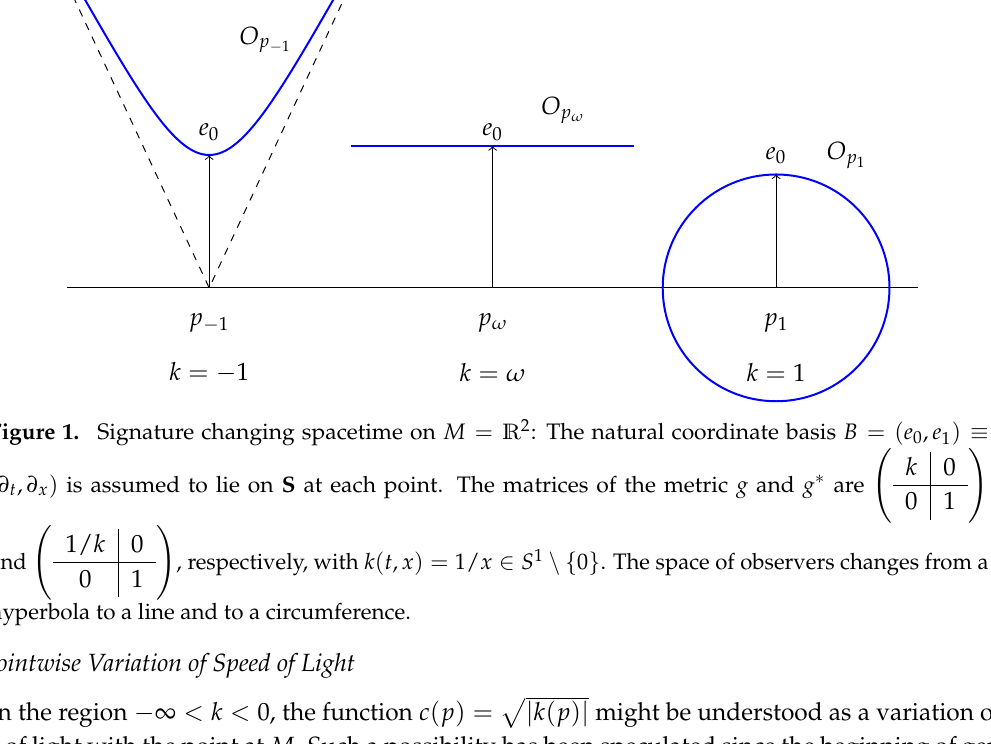
, respectively, with k ( t , x ) = 1/ x ∈ S 1 \ { 0 } . The space of observers changes from a hyperbola to a line and to a